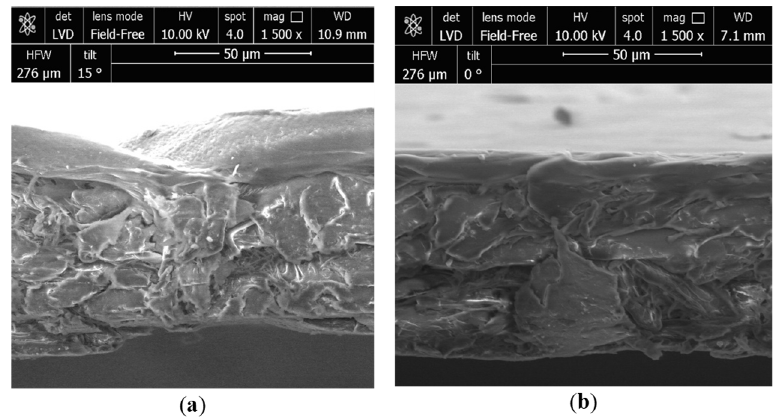
Figure 3. Cross section of pure PHBV ( a ) and PCL ( b ) of the second